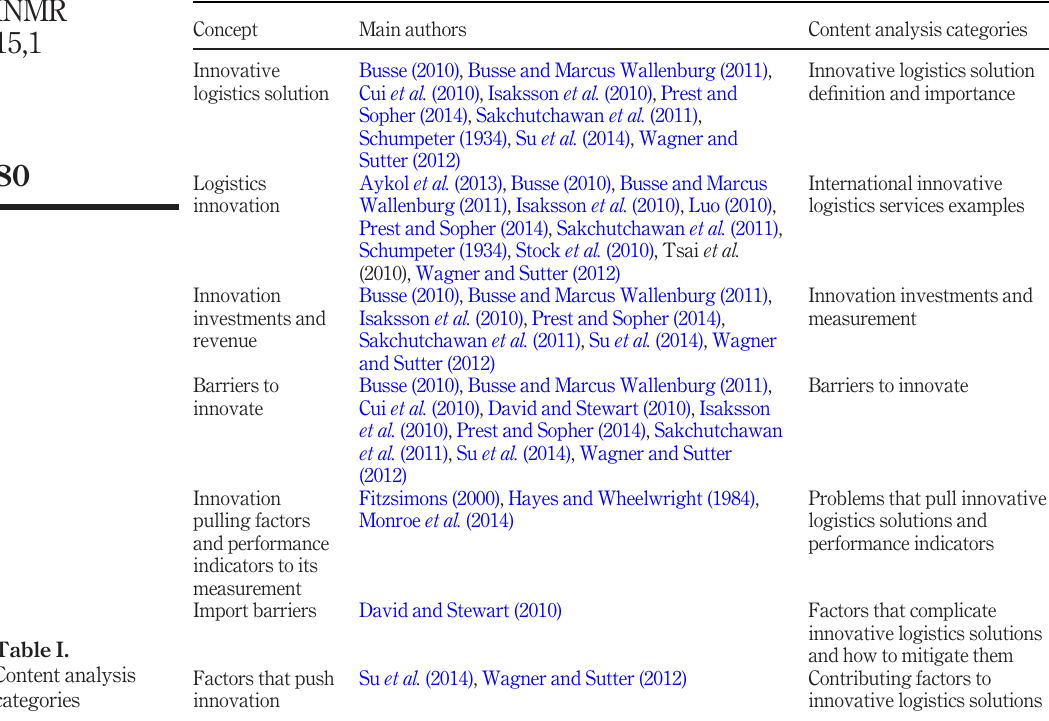
Table I lists the categories of the content analysis used in this paper and the main authors that inspired